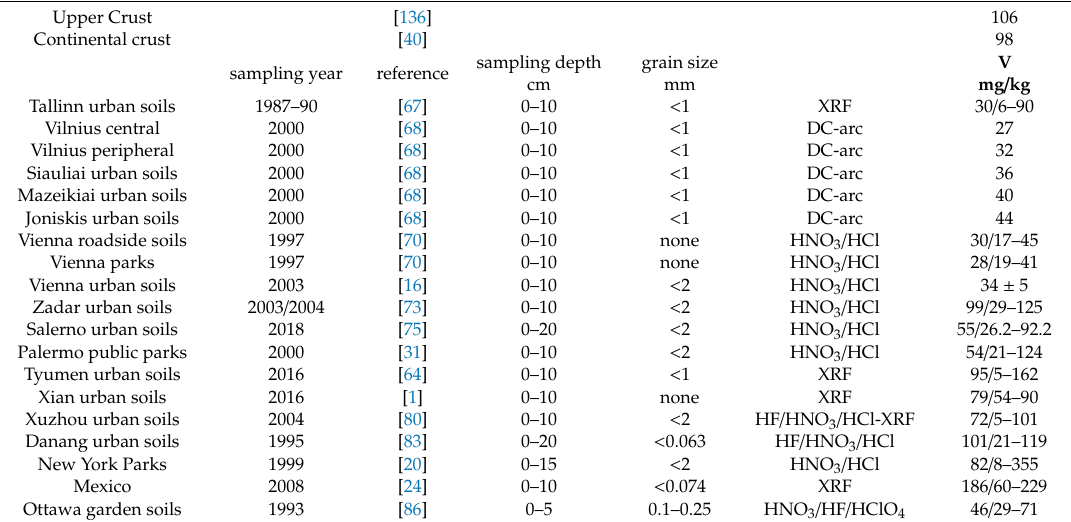
Table A19. Vanadium in urban soils.